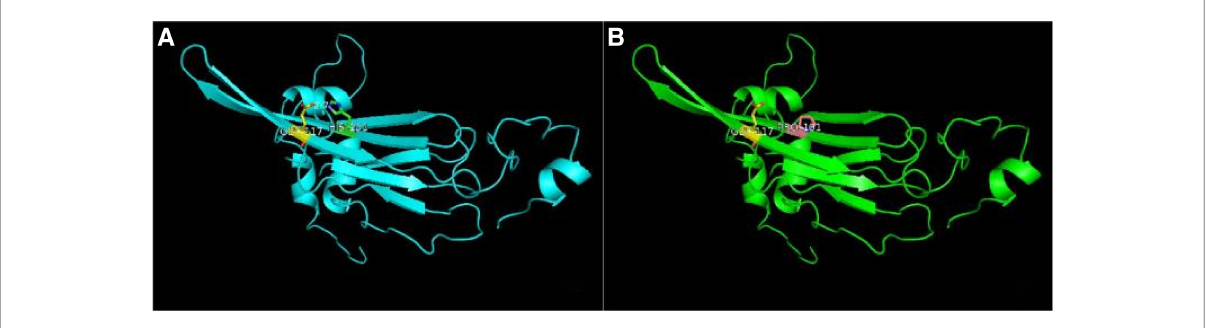
FIGURE 4 Effect of the CRYAB c.302A>C (p.H101P) mutation on the three-dimensional structure of the protein predicted by functional model software. ( A ) Wide type and ( B ) mutant type. A hydrogen bond was absent in the mutation site of α